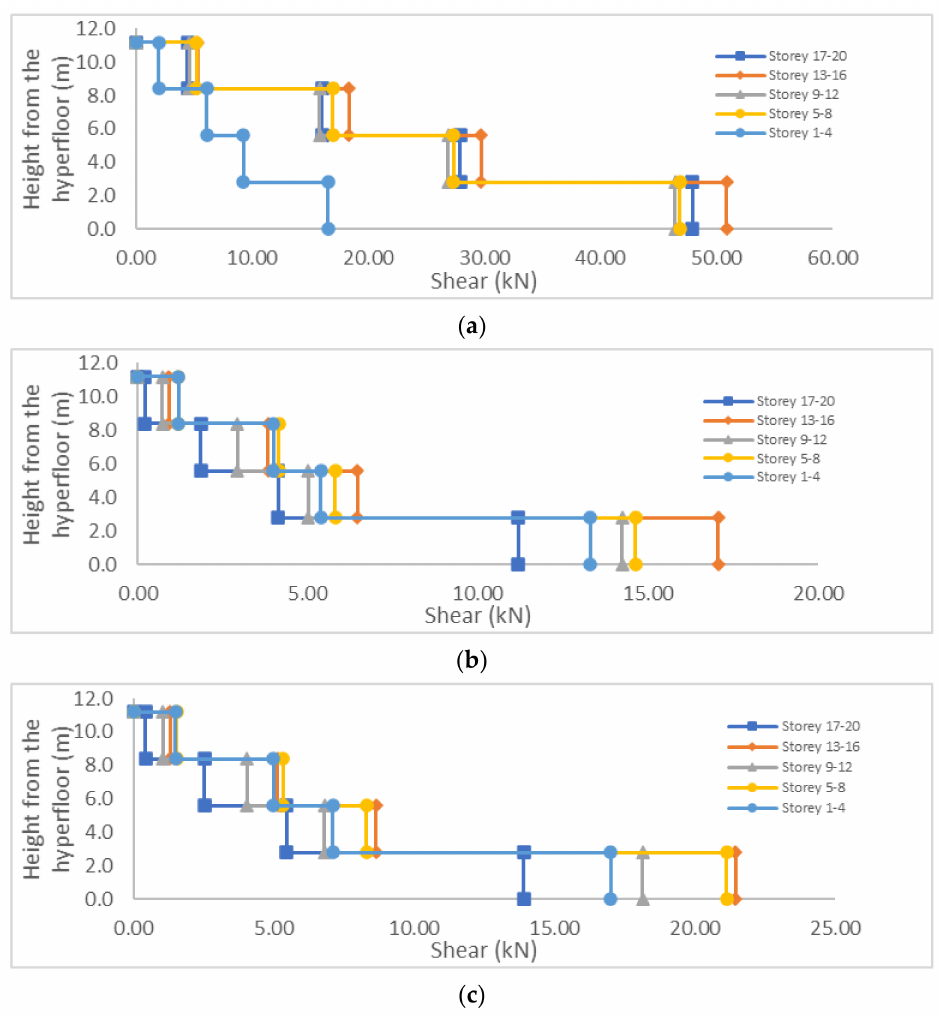
Figure 14. Shear experienced by the shearwall segments of the long modules under factored seismic- load combination 1.0 E + 1.0 D + 0.5 L + 0.25 S. The end shearwall segments of 3.475 m length are shown in ( a ), the segment of 3.0 m length are shown in ( b ) and the segment of 3.5 m length are shown in ( c